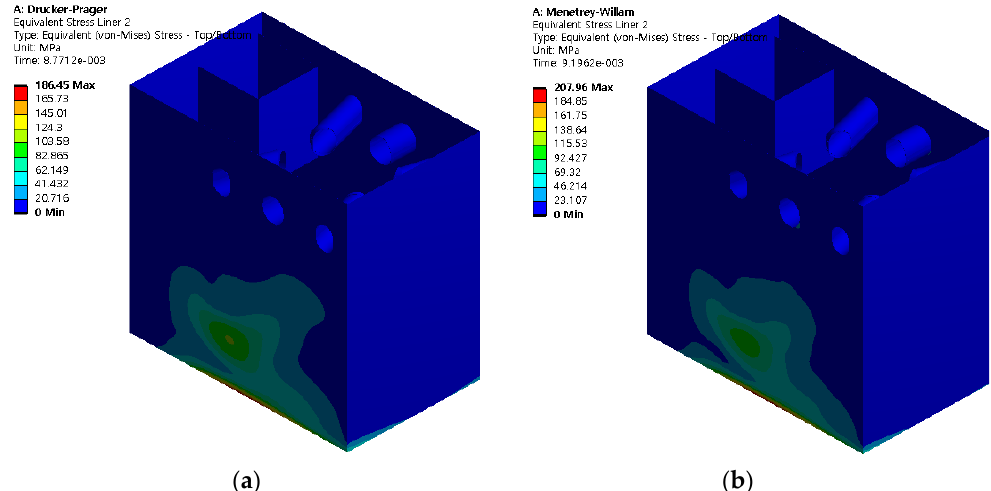
Figure 9. Maximum principal stress distribution in the damaged regions of the concrete walls. ( a ) The Drucker-Prager model. ( b ) The Menetrey-William model.